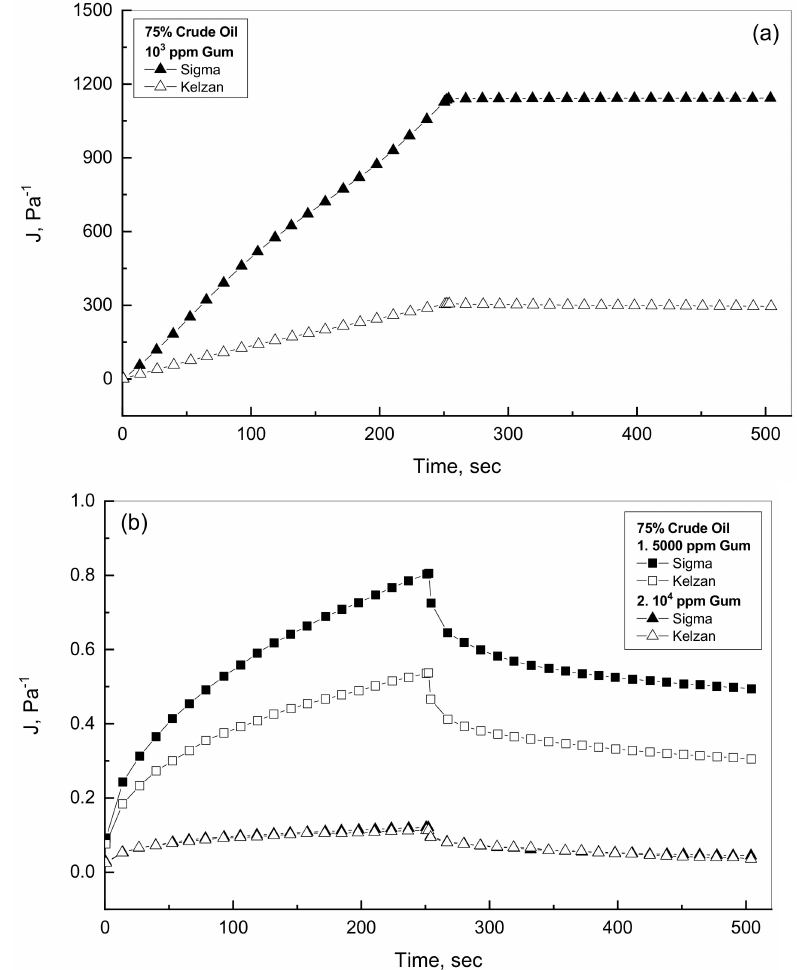
Figure 8. Creep-recovery behavior of Sigma and Kelzan for 75% oil emulsions. ( a ) Low gum concentration; ( b ) High gum concentration.